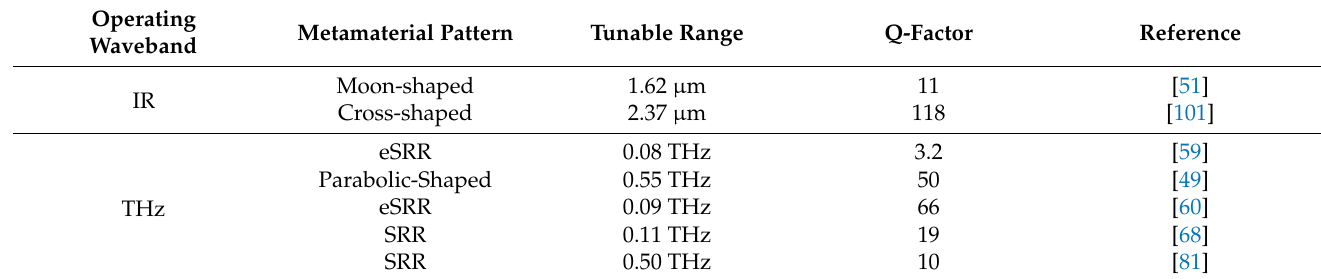
Table 2. Comparison of MEMS-based tunable